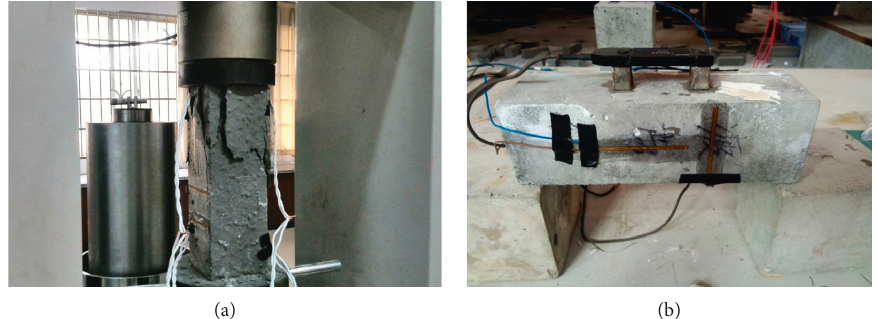
Figure 2: Experimental setup. (a) A prism concrete specimen is subjected to directly compression. (b) The layout of the electrical resistance strain gauges and the extensometer.